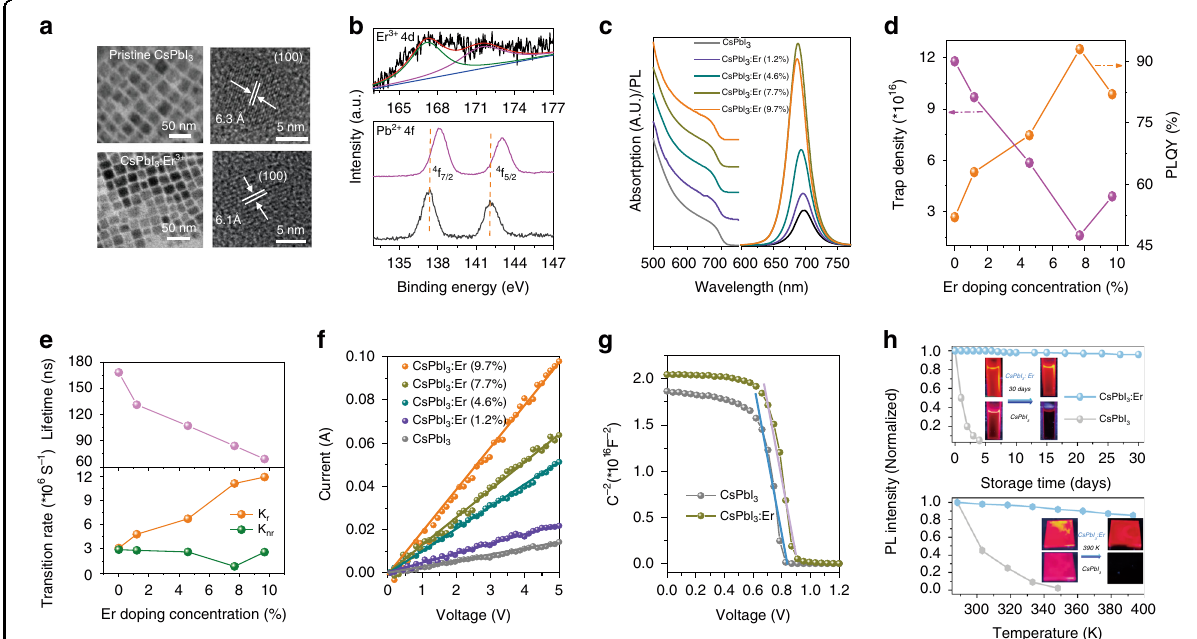
Fig. 2 Er 3 + doped CsPbI 3 PQDs. a TEM and HR-TEM images of CsPbI 3 and CsPbI 3 : Er 3 + (7.7%) PQDs. b XPS spectra of Er 3 + (4d) and Pb 2 + (4f) of CsPbI 3 and CsPbI 3 : Er 3 + (7.7%) PQDs. Absorption and emission spectra ( c ), trap density and PLQY ( d ), and PL decay lifetimes and transition rates ( e ) of CsPbI 3 and CsPbI 3 :Er 3 + PQDs with different Er 3 + concentrations of 1.2%, 4.6%, 7.7%, 9.7%. f I – V curves of CsPbI 3 and CsPbI 3 :Er 3 + PQDs as a function of different Er 3 + concentrations in ITO/ETL/ PQDs /Ag devices. g Mott – Schottky measurement of CsPbI 3 and CsPbI 3 : Er 3 + (7.7%) PQDs. h Normalized PL intensity of CsPbI 3 and CsPbI 3 : Er 3 + (7.7%) PQDs as a function of storage time and temperature; Inset is PL images of CsPbI 3 and CsPbI 3 : Er 3 + (7.7%) PQDs after 30 days and 390 K under 365 nm UV